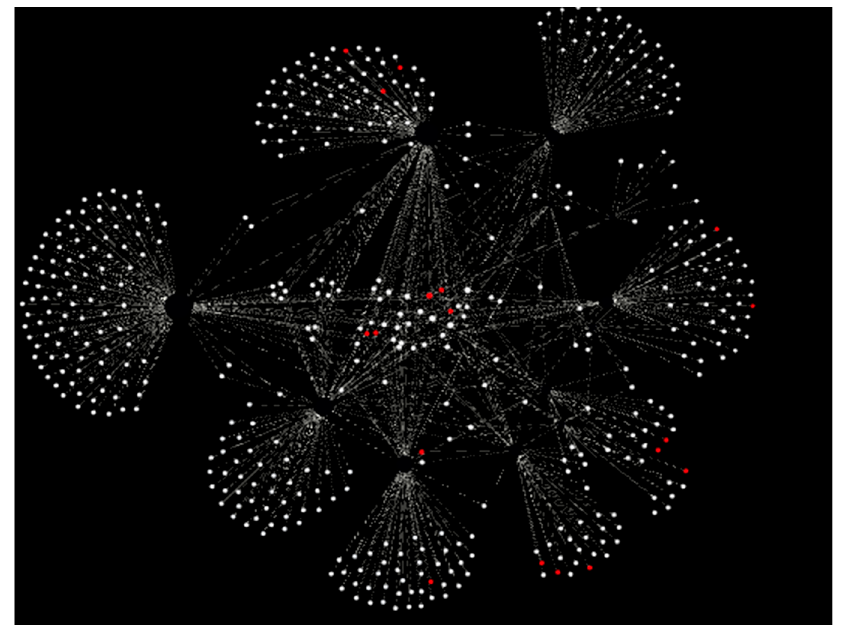
Figure 4. All thunder gods (in red). Table 1. Categories and